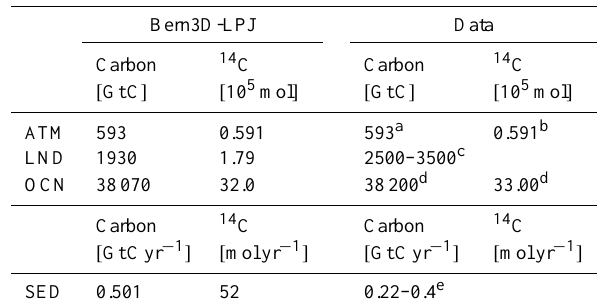
Table 1. Preindustrial model versus data-based carbon and 14 C in- ventory estimates. The model-based oceanic inventories are calcu- lated as the average of the experiments BIO and